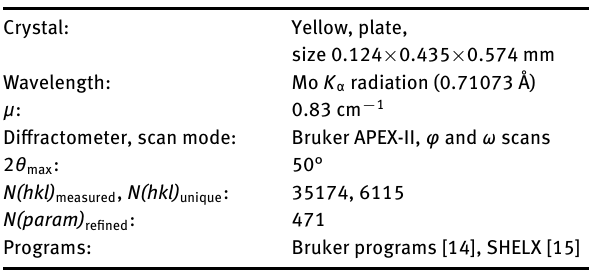
Table 1: Data collection and handling.